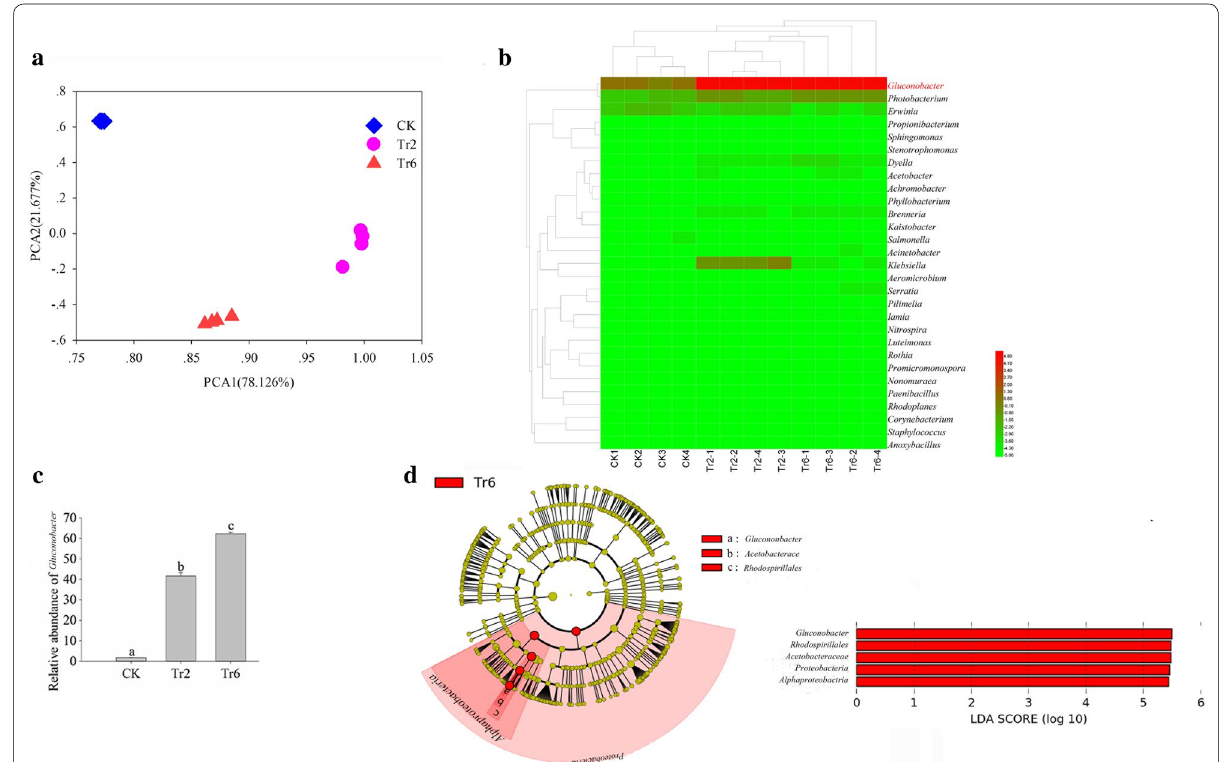
Fig. 2 Bacterial communities in guava inoculated with fly eggs. a Principal components analysis of bacterial communities. b Cluster analysis clad- ogram showing the identified bacteria. The data were log transformed before plotting. c Difference in abundance of Gluconobacter sp. d Key factor screening for differences between samples by LEfSe analysis, the biomarkers with LDA scores above 4.0 were showed in green or red dots in the cladogram. Means ( SEM) labeled with different letters are significantly different; CK: guava fruit sample collected 1 day after inoculation with fly ± eggs; Tr2: guava fruit sample collected 2 days after inoculation with fly eggs; Tr6: guava fruit sample collected 6 days after inoculation with fly